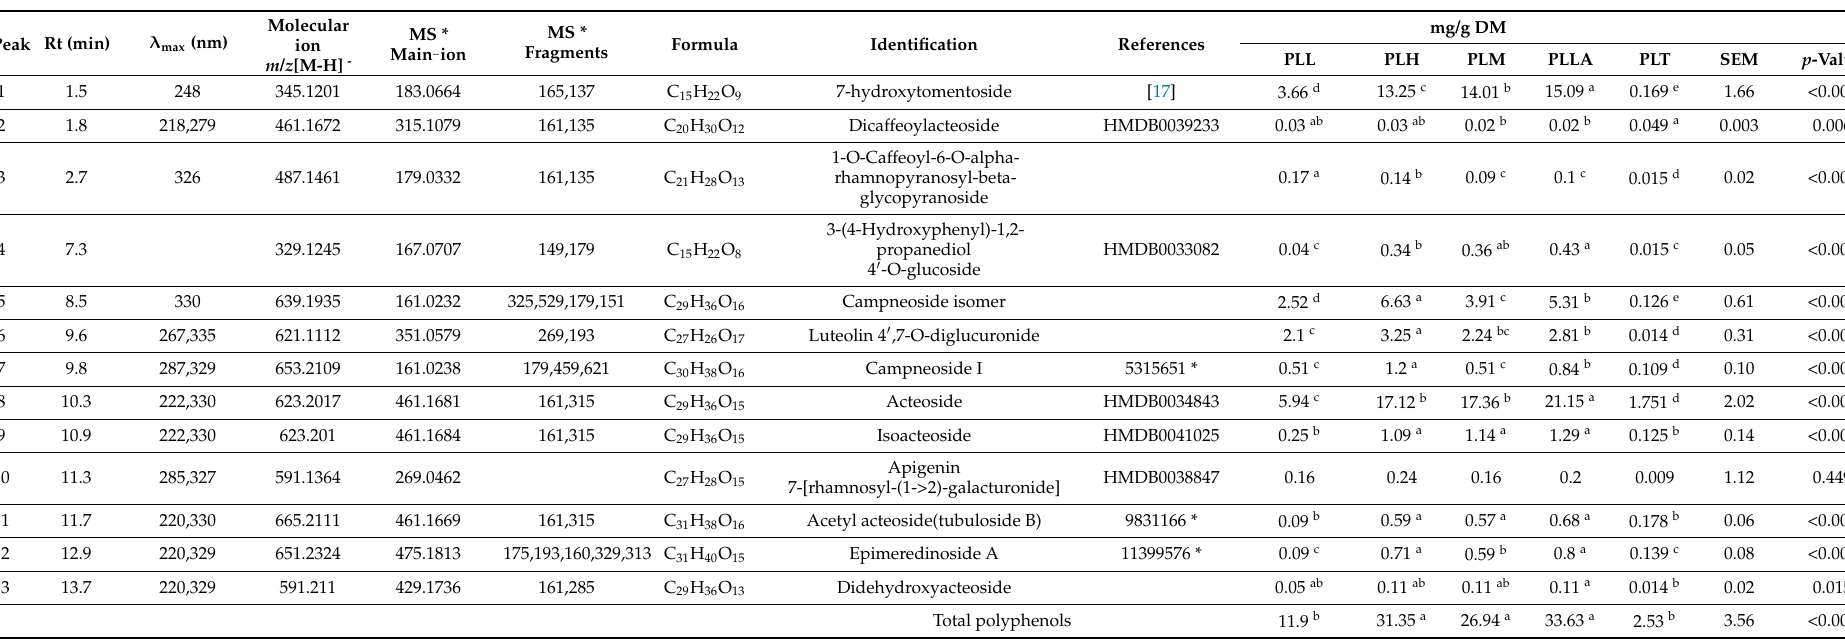
Table 2. Contents of the main bioactive compounds (mg/g DM) identified in Paulownia leaves with lower concentration of bioactive components (PLL), Paulownia leaves with high concentration of bioactive components (PLH), Paulownia leaves with medium concentration of bioactive components (PLM), Paulownia leaves lamina (PLLA) and Paulownia twigs